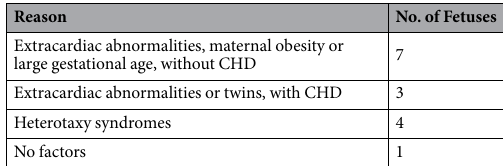
Table 1. Reasons for inaccurate diagnosis by Ultrasound.